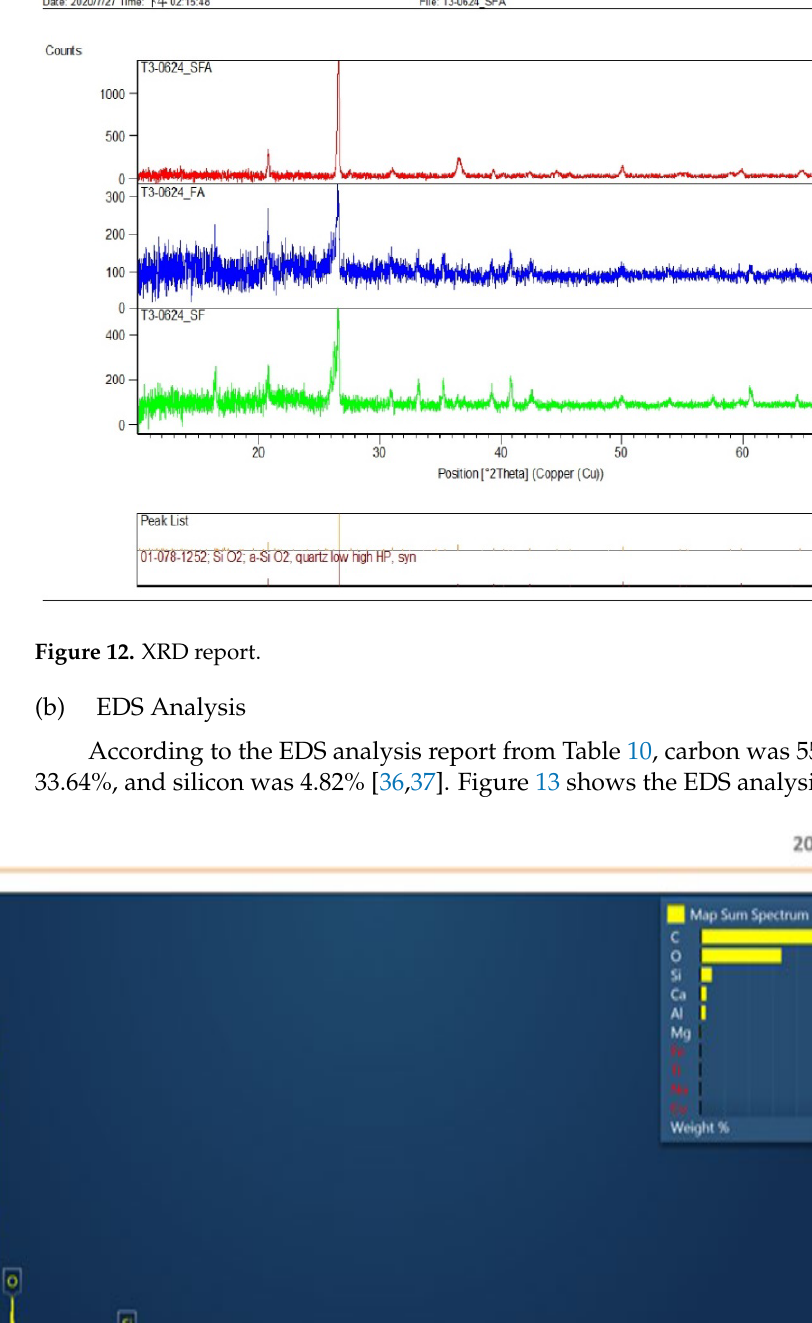
Table 10. EDS Analysis